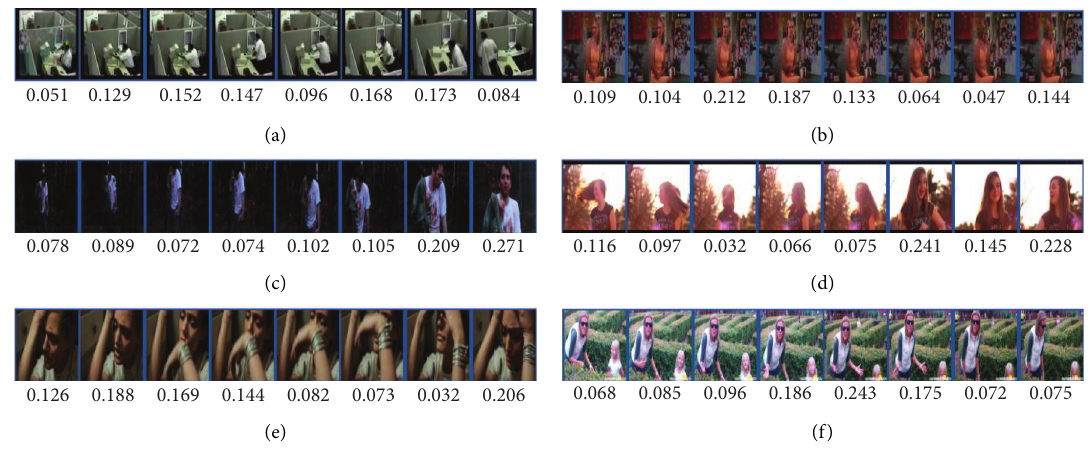
Figure 5: Samples with their emotion scores predicted by CAAN. Table 4: Top-1 accuracy (%) compared with state-of-the-art Table 6: Top-1 accuracy (%) compared with state-of-the-art methods on HEIV methods on Ekman-6 and Method